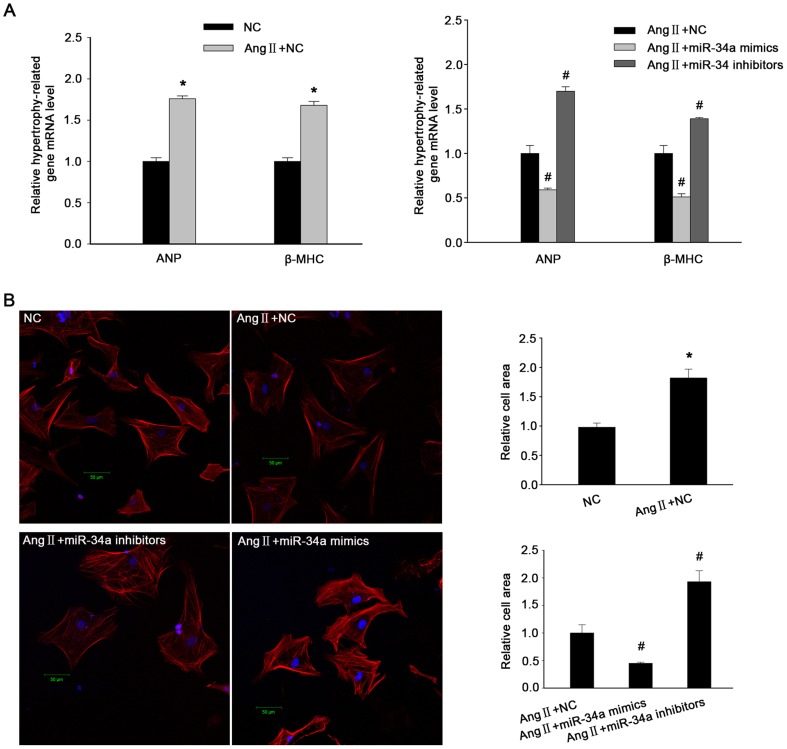
Effects of miR-34a on regulation of Ang II-induced myocardial hypertrophy.(A) qRT-PCR. The cardiomyocytes were treated with control lentivirus or Ang II plus control lentivirus or Ang II plus miR-34a mimics or Ang II plus miR-34a inhibitors and then subjected to qRT-PCR analysis of the hypertrophy-related genes ANP and β-MHC mRNA. *P<0.05 compared to NC; #P<0.05 compared to Ang II + NC. (B) Confocal microscopy. The cardiomyocyte morphology was measured by Confocal microscopy after staining with Alexa Fluor555 Phalloidin and DIPI. The graph summarizes the confocal microscopy data. *P<0.05 compared to NC; #P<0.05 compared to Ang II + NC.